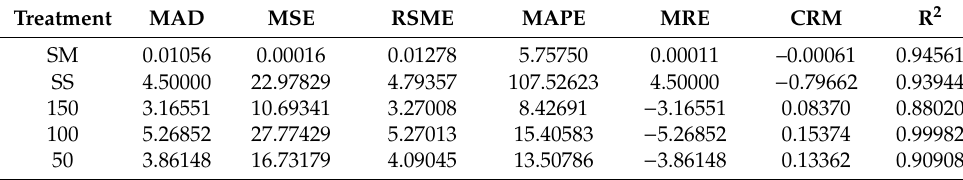
Table 7. Statistical indicators of soil moisture content, soil salinity, and three irrigation regimes.